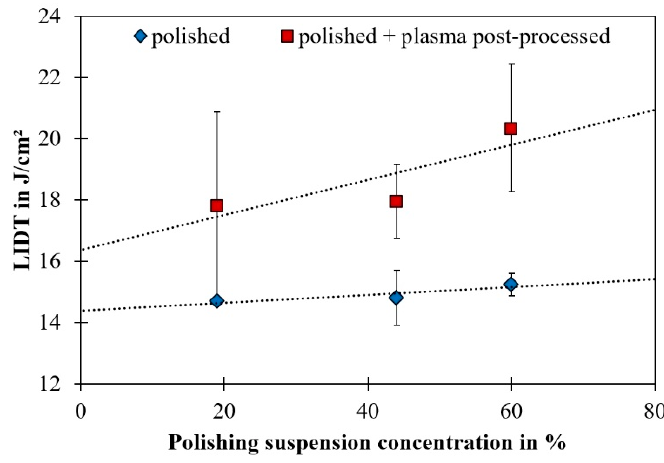
Figure 6. Laser-induced damage threshold (LIDT) of zinc crown glass samples before and after plasma post-processing vs. polishing suspension concentration including trend (dotted